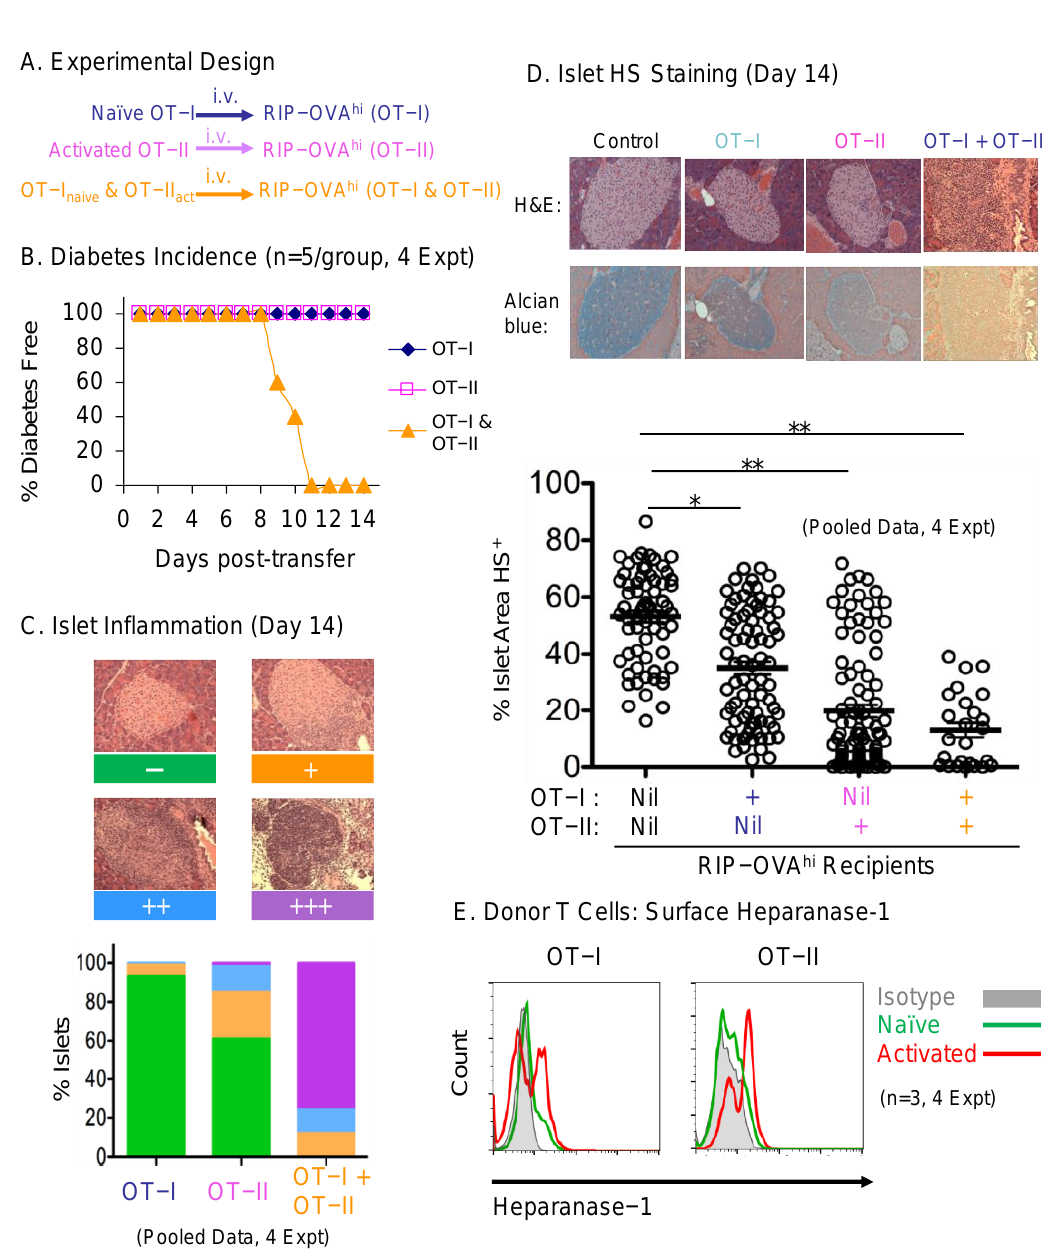
Figure 1. Antigen- specific T cell transfer model for studying islet infiltration and HS degradation ( A ) Experimental design. Adoptive transfer of naïve OT-I cells and in vitro activated OT-II cells into RIP-OVAhi mice to induce diabetes. ( B ) Frequency of diabetes free RIP-OVAhi mice in the 3 groups (5 mice/group) of recipients receiving naïve OT-I cells (blue), activated OT-II cells (purple), or both OT-I and OT-II (orange) T cells. ( C ) Intensity of islet inflammation in the pancreas at day 14. Islet infiltration was classified into 4 grades: intact islet, <50% of the islet infiltrated, >50% of the islet infiltrated, and 100% of the islet destroyed. Data are compiled from 4 independent experiments. ( D ) Representative pancreas histology at day 14 stained with H&E or Alcian blue from RIP-OVAhi mice transferred with OT-I or OT-II T cells. Quantification of HS+ area stained with Alcian blue of indi- vidual islets in 4 sections of each recipient pancreas. Each dot represents the value of one individual islet (5 mice per group). Signi ficance was assessed by Student’s t- test, * p < 0.05, ** p < 0.01. ( E ) His- togram overlay of HPSE-1 staining in OT-I and OT-II T cells on the cell surface before and after OVA stimulation in vitro (Grey infill: isotype control; green line: naïve; red line: activated).In accordance with hyperglycemia, severe islet inflammation was found in recipients two weeks after receiving both naïve OT-I and activated OT-II T cells (Figure 1C). All islets had various levels of lymphocyte infiltration and 80% of the islets were destroyed. Although no diabetes was found when OT-I or